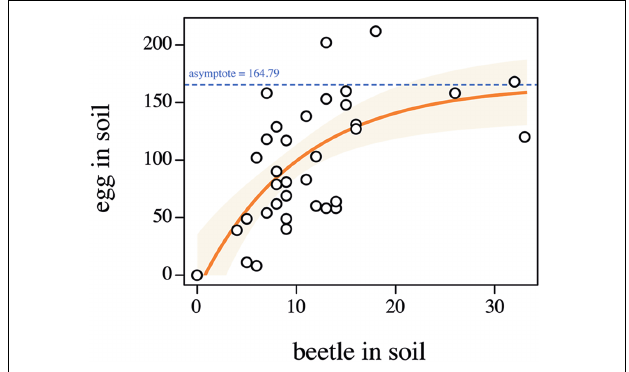
FIGURE 3 | Relationship between the number of Heteronychus arator beetles in the soil in the lower section of the microcosm and the number of laid eggs. Open circles indicate the observed data. The light orange zone represents the 95% confidence interval of the fitted model (orange solid line). The dashed blue line represents the model asymptote.